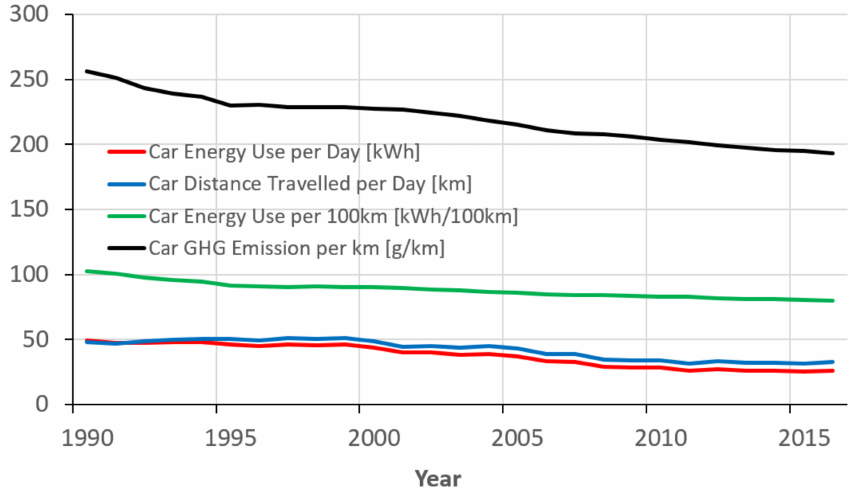
Figure 2. Distance Traveled, Energy Use & GHG Emissions of B.C. Cars (1990–2016), data from [33]. NRC data is evaluated for cars, buses (school, urban transit, and inter-city buses), and trucks (passenger light trucks, freight light trucks, medium trucks, and heavy trucks)